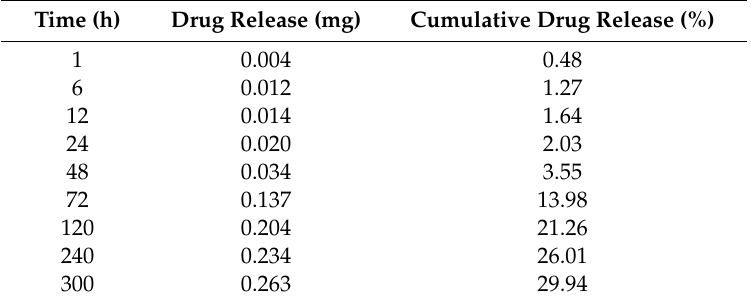
Table 1. In vitro TAM drug release data.